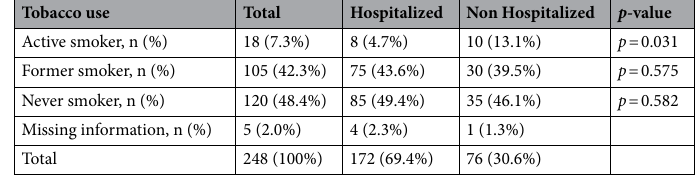
Table 1. Baseline characteristics of study